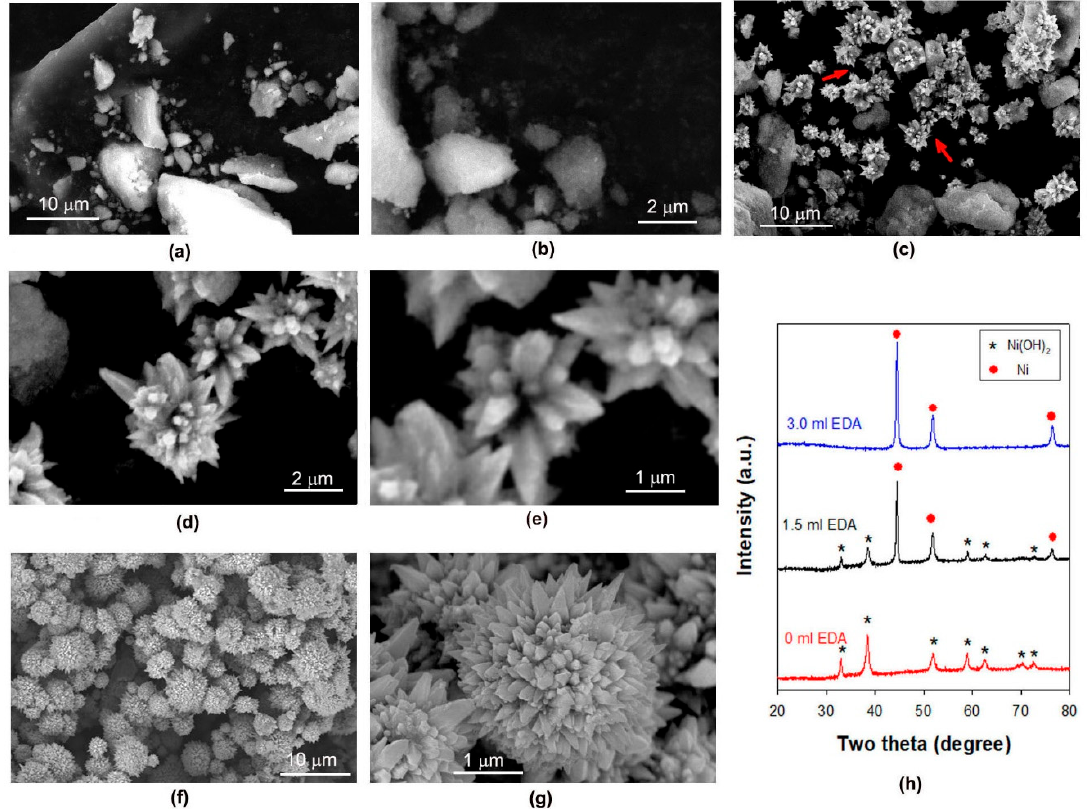
Figure 1. SEM images ( a – g ) and XRD patterns ( h ) of the products formed in 200 mL of 15 M NaOH solution containing different amounts of EDA: ( a , b ) 0 mL, ( c – e ) 1.5 mL, and ( f , g ) 3 mL. Reaction duration is 2 h.